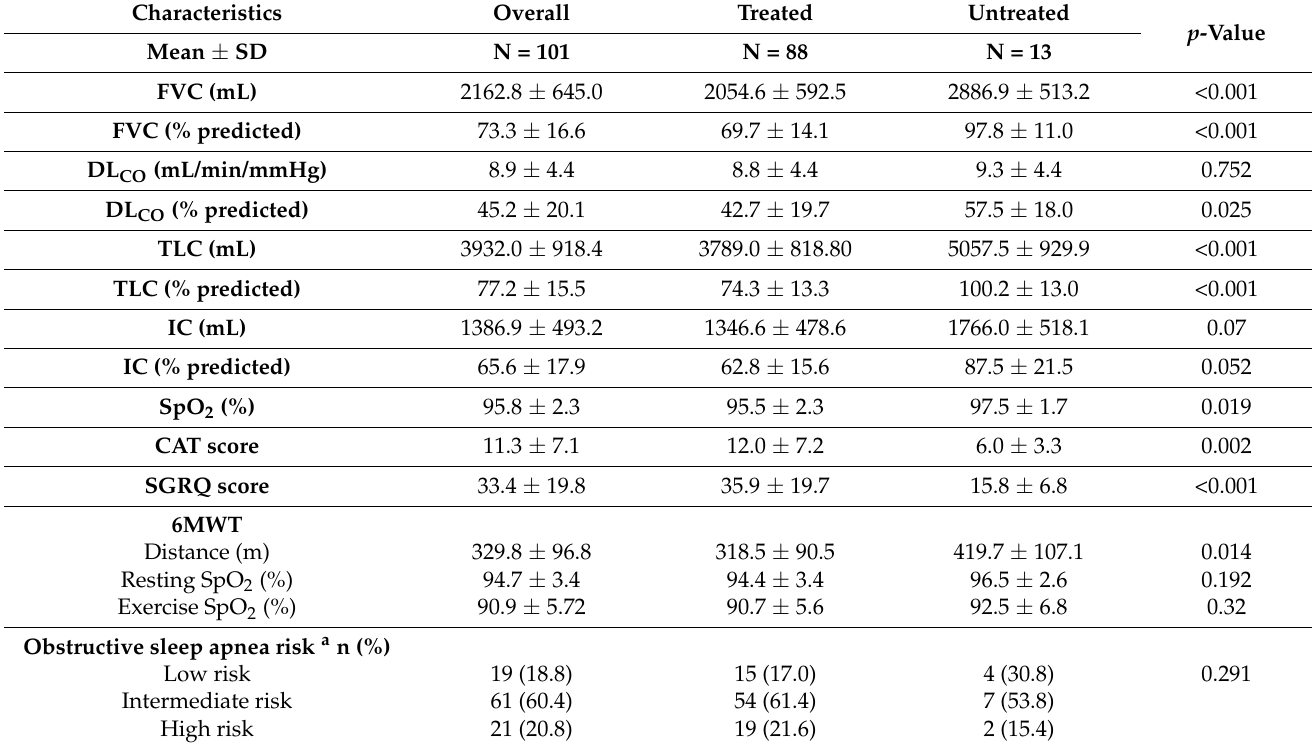
Table 2. Baseline readings for primary and secondary outcomes of lung